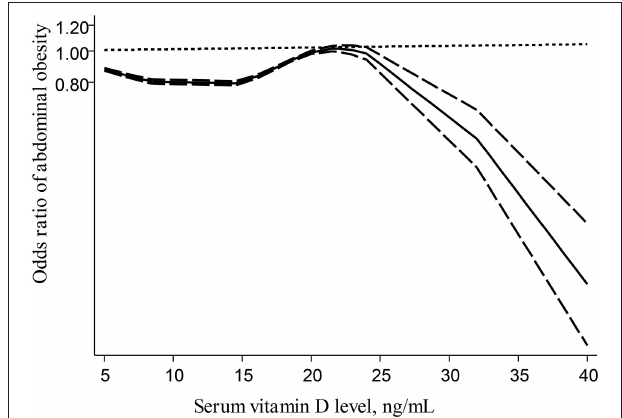
FIGURE 5 | Nonlinear dose–response relationship between serum vitamin D levels and abdominal obesity in children and adolescents; - - -, Linear model; ____, spline